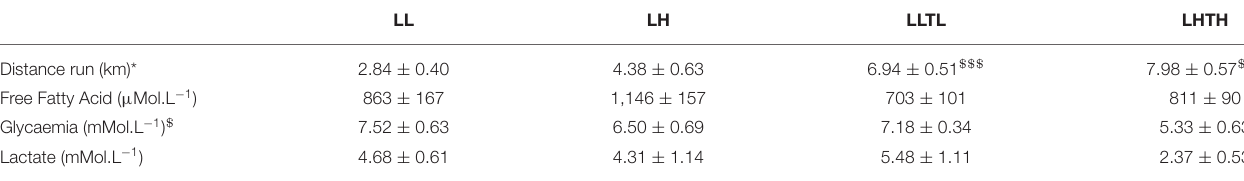
TABLE 4 | Maximal muscle oxidative capacity, citrate synthase and 3-hydroxyl-acyl coenzyme A dehydrogenase activities in the plantaris muscle. LL LH LLTL LHTH